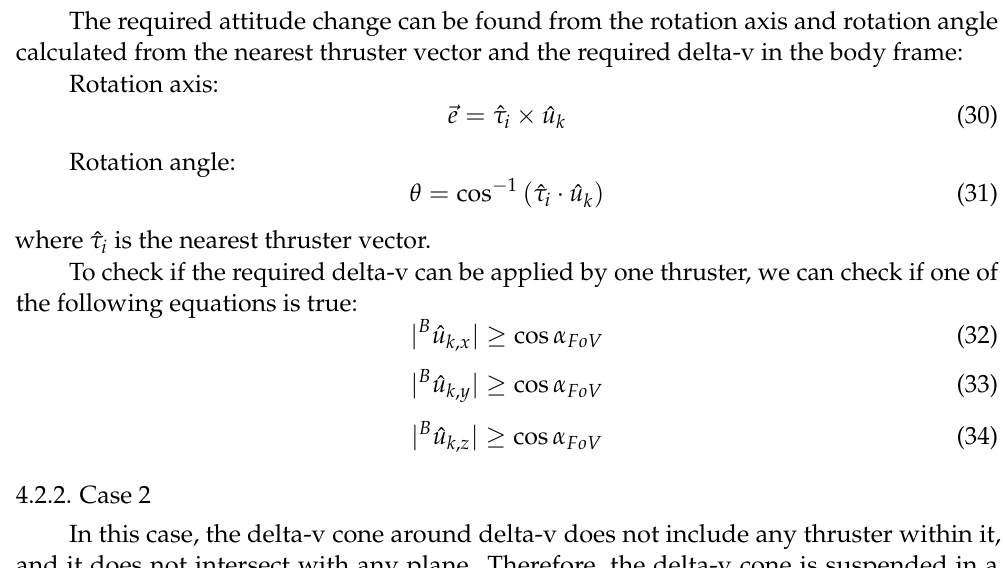
Figure 5. Case 1: a thruster inside the delta-v